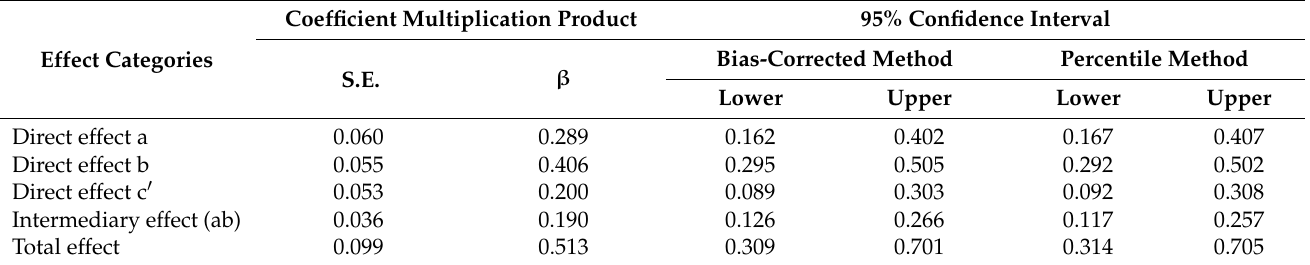
Table 9. Reported results of mediating effect